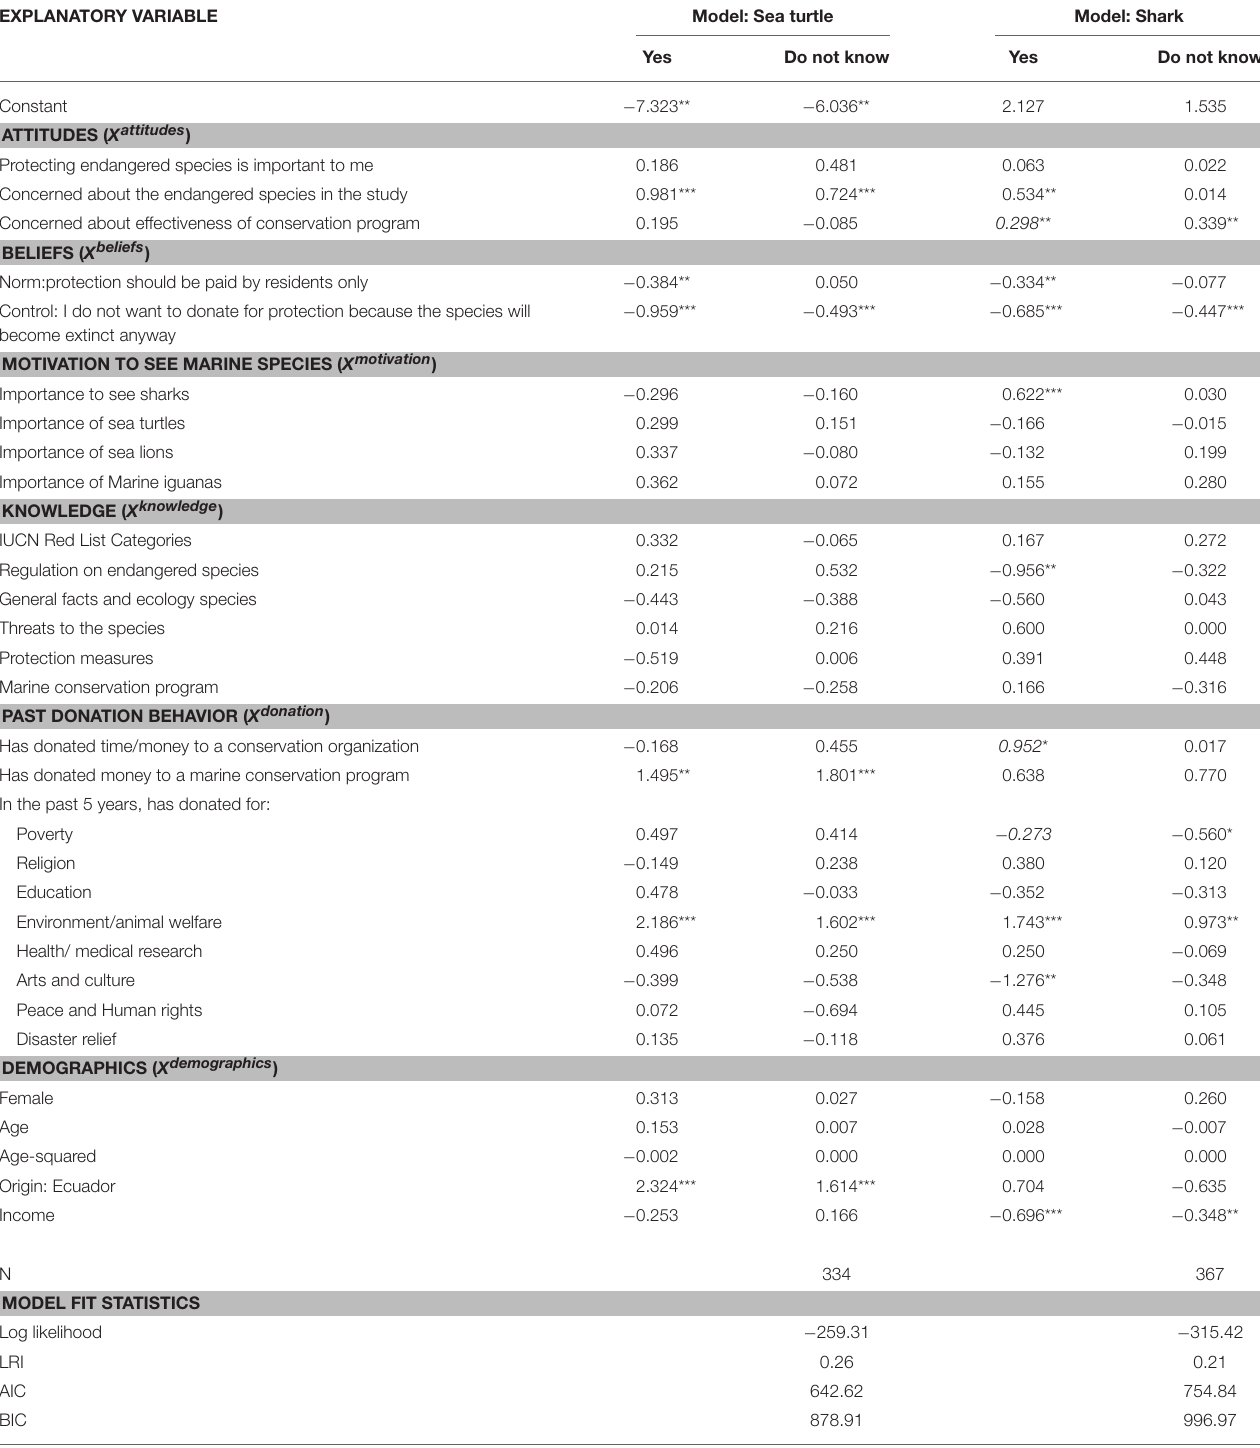
TABLE 3 | Multinomial logit